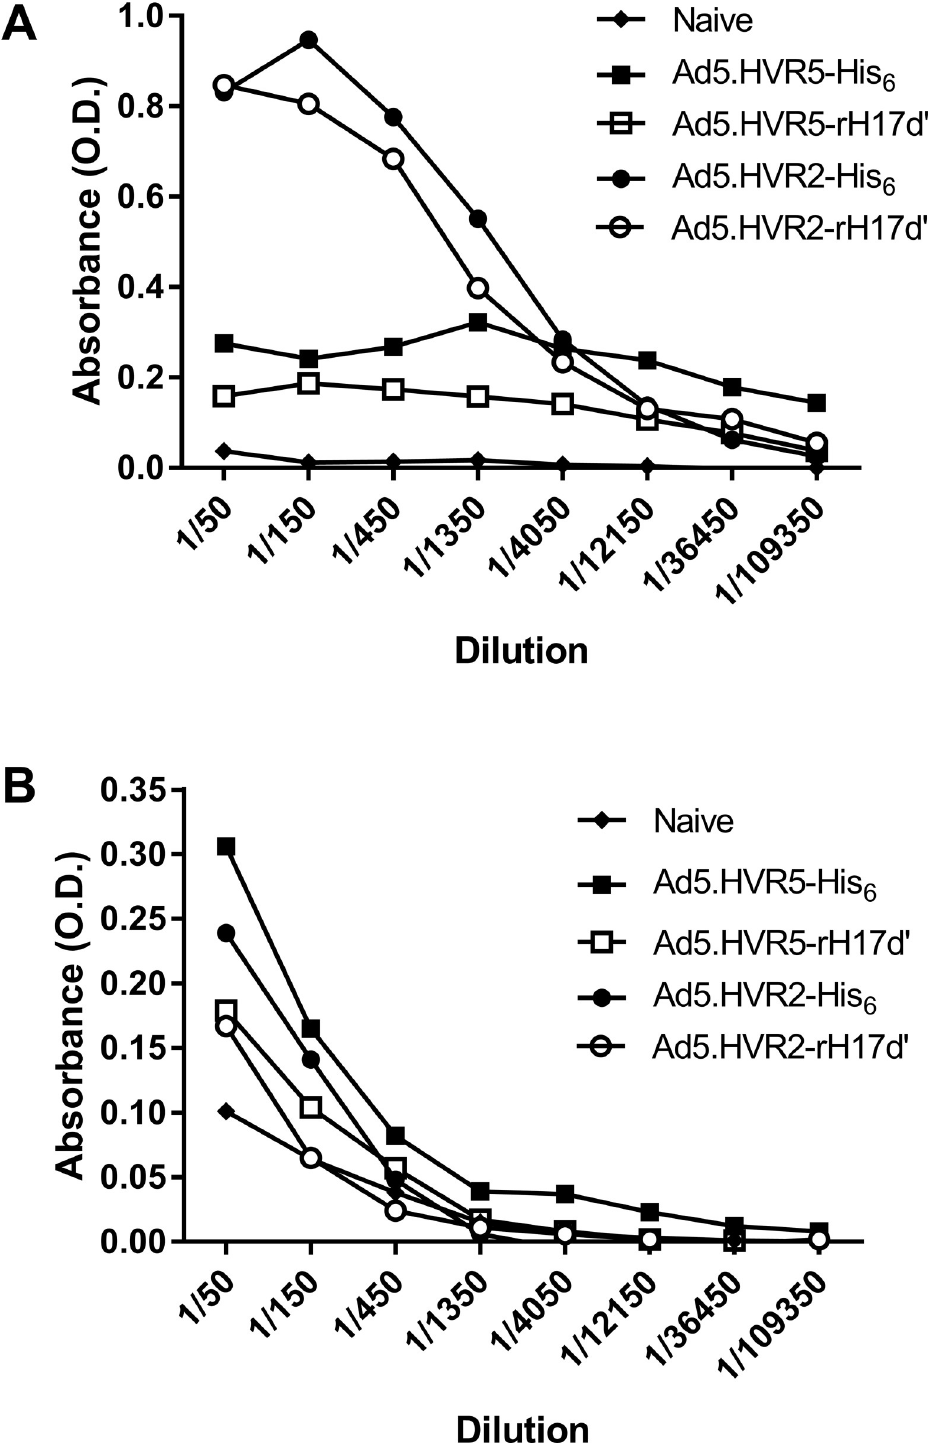
Fig 4. Humoral immune response to Ad5 vectors carrying rH17d’ or His 6 peptide modifications on their capsid surfaces. Mice were immunized with 4 x 10 9 VP of each adenoviral vectors, followed by serum collection 14 days later for quantification of (A) IgG and (B) IgM levels. Control (base line) values for IgG and IgM were obtained from na ï ve (non-immunized) mice.